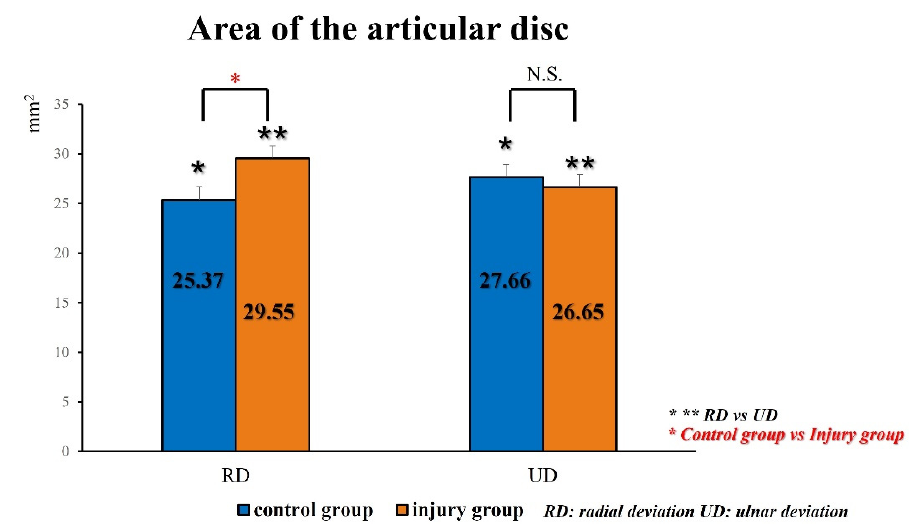
Figure 6. In contrast to the control group, the areas during radial deviation were statistically larger than those during ulnar deviation in the injury group.